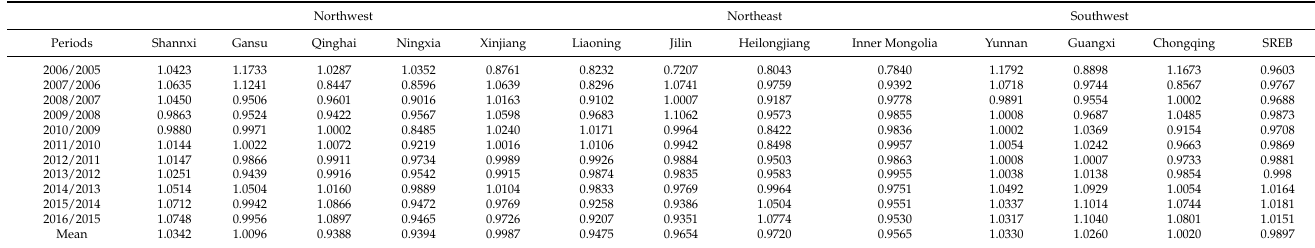
Table 3. Transportation-carbon-reduction performance by provinces along the